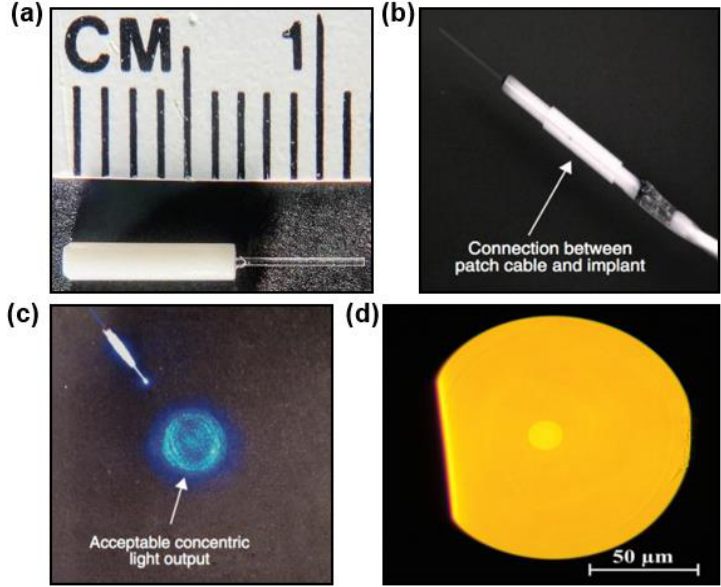
Figure 2. Inorganic fibers. ( a ) A silica fiber for tissue implant. ( b ) A silica fiber connected with a patch cable. Reproduced with permission [27]. Copyright 2011, Nature Publishing Group. ( c ) Transmission of light through a silica fiber. Reproduced with permission [27]. Copyright 2011, Nature Publishing Group. ( d ) The cross-sectional view of a calcium-phosphate glass based optical fiber. Reproduced with permission [38]. Copyright 2016, OSA.